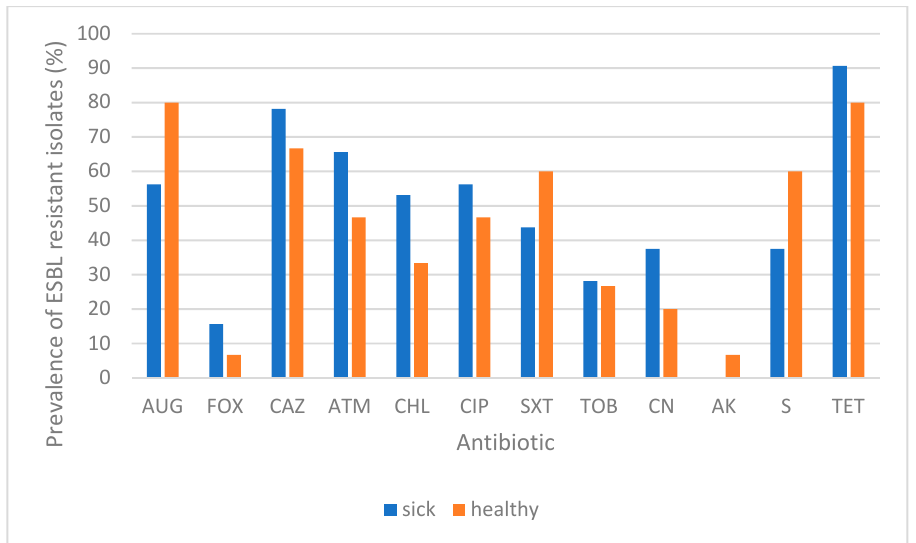
Figure 1. Prevalence of antibiotic-resistance among ESBL-producing E. coli isolates in sick and healthy dogs. Antibiotics tested: AUG, amoxicillin-clavulanic acid; FOX, cefoxitin; CAZ, ceftazidime; ATM, aztreonam; CHL, chloramphenicol; CIP, ciprofloxacin; SXT, trimethoprim-sulfamethoxazole; TOB, tobramycin; CN, gentamicin; AK, amikacin; S, streptomycin; TET, tetracycline. No significant association was detected between antibiotic resistance and type of animal (sick or healthy) ( p > 0.05). Different variants of bla CTX-M genes were detected among 45 of these 47 ESBL-producing isolates (95.4%): bla CTX-M-15 ( n = 26 isolates), bla CTX-M-1 ( n = 10), bla CTX-M-32 ( n = 3),